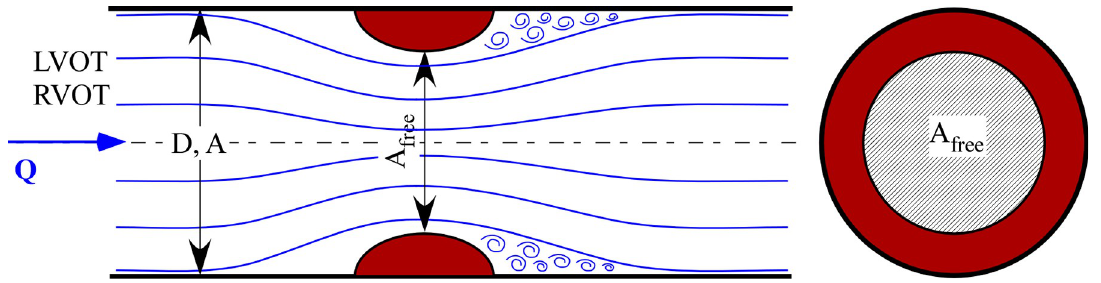
Fig 2. Streamlines of the flow due to the presence of an ideal round